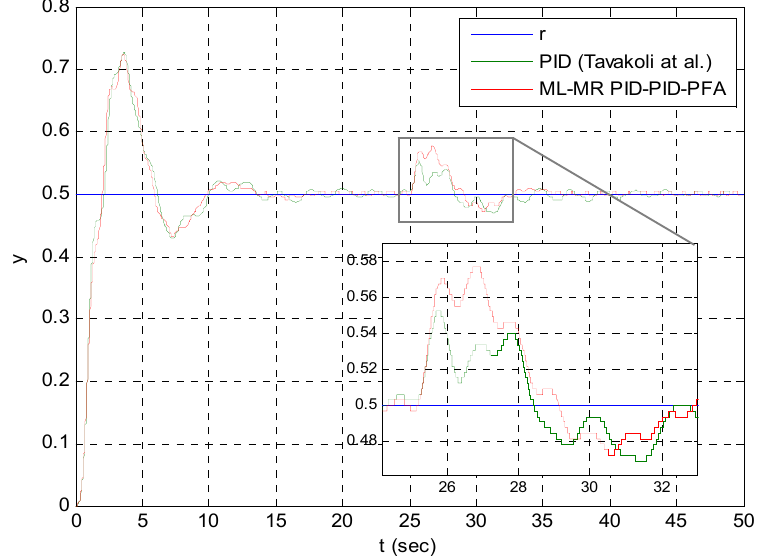
Figure 20. Experimental results obtained for control of the main rotor of TRMS setup.